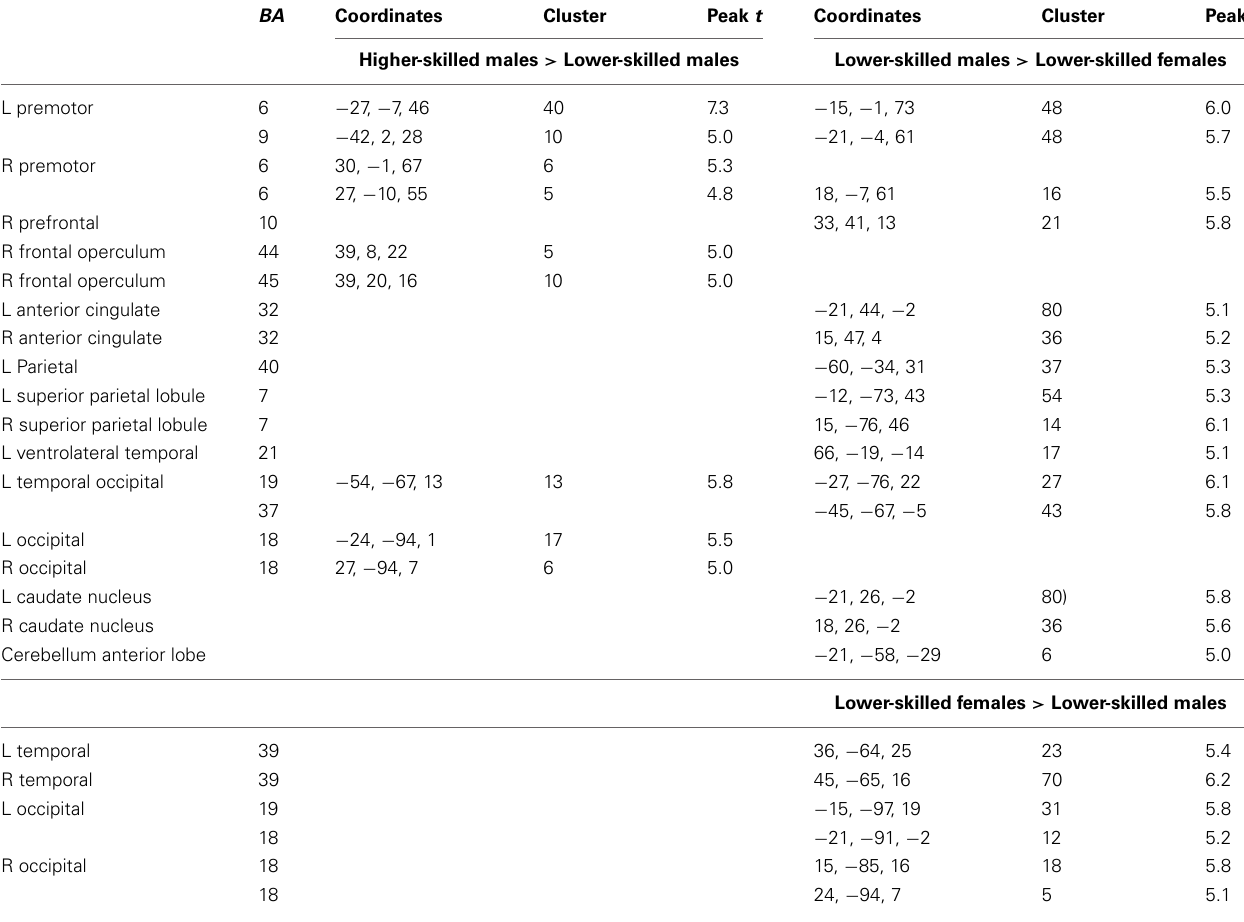
Table 7 | Expertise group differences at p < 0.05 FWE